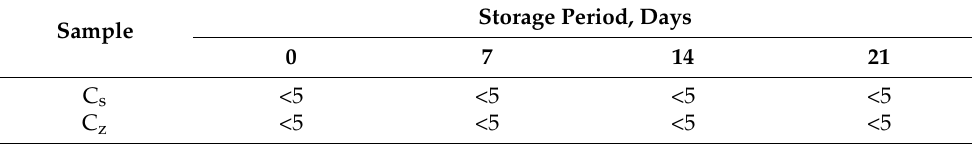
Table 5. Enterobacteriaceae enumeration during storage,